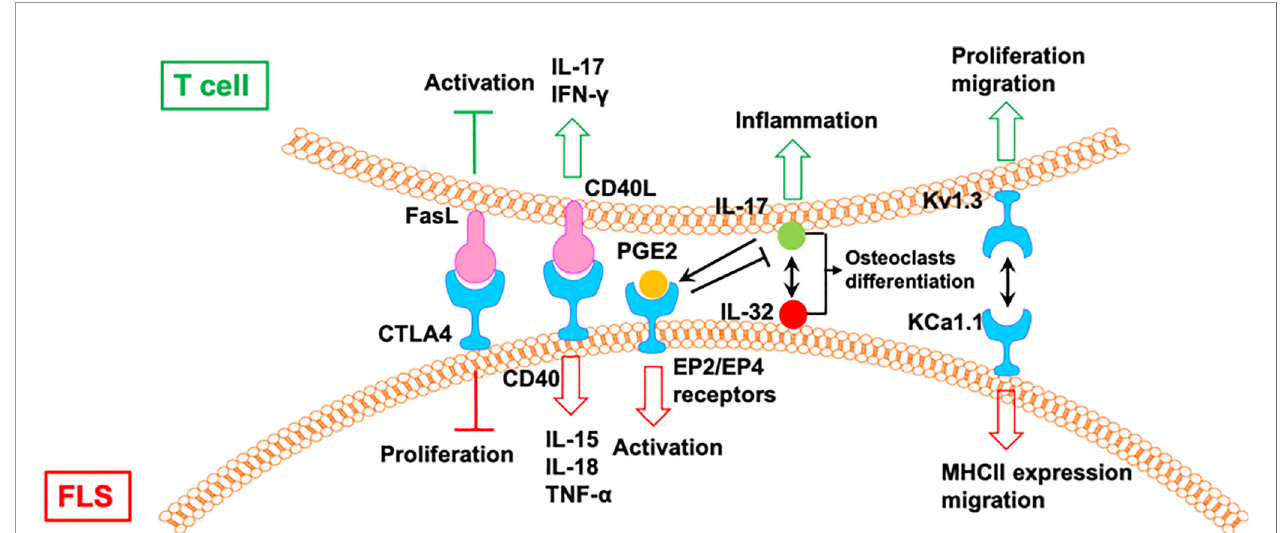
FIGURE 6 | The mutual regulation of T cells and FLS in RA. CIA, collagen-induced arthritis; T em : effector memory T; AIA, adjuvant-induced arthritis.